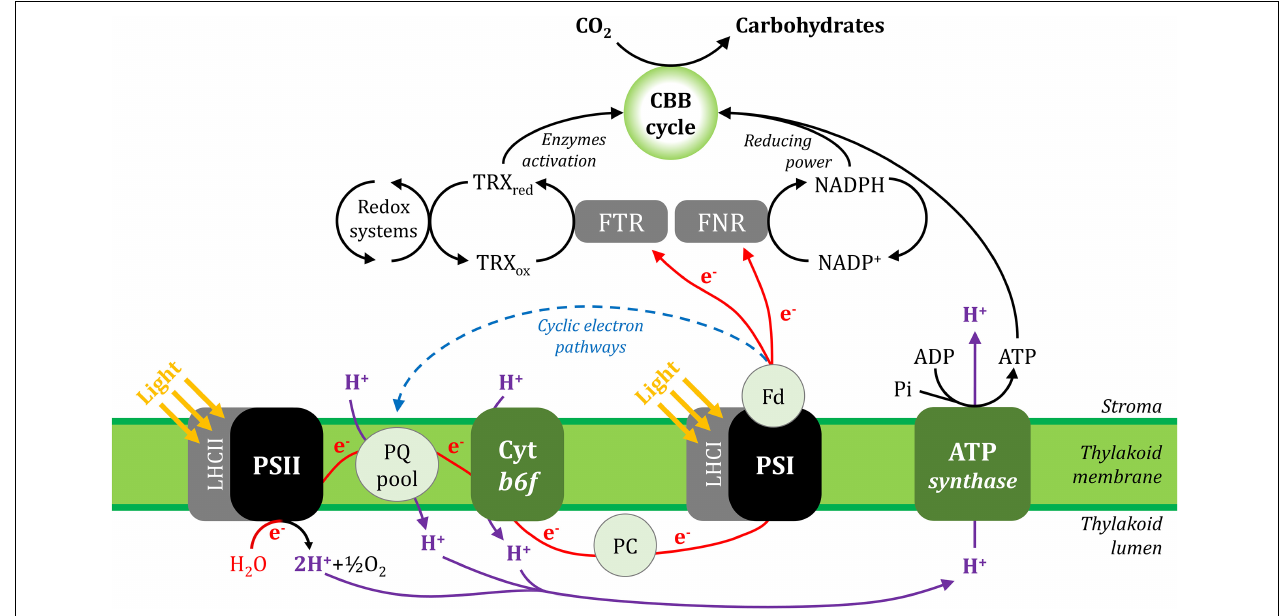
FIGURE 1 | A simplified scheme of the photosynthetic electron transport chain in the thylakoid membrane and its interaction with CO 2 assimilation in the Calvin-Benson-Bassham cycle. Linear electron (e − ) transport is shown with red lines and cyclic electron transport is represented with a blue dashed line. The proton (H + ) fluxes are represented in purple lines. ADP, adenosine diphosphate; ATP, adenosine triphosphate; CBB cycle, Calvin-Benson-Bassham cycle; Cyt b6f , cytochrome b6f ; Fd, ferredoxin; FNR, ferredoxin:NADP + oxidoreductase; FTR, ferredoxin:thioredoxin reductase; LHCI, light-harvesting complex I; LHCII, light-harvesting complex II; NADP + , oxidised nicotinamide adenine dinucleotide phosphate; NADPH, reduced nicotinamide adenine dinucleotide phosphate; PC, plastocyanin; Pi, inorganic phosphate; PQ, plastoquinone; PSI, photosystem I; PSII, photosystem II; TRX ox , oxidised thioredoxin; TRX red , reduced